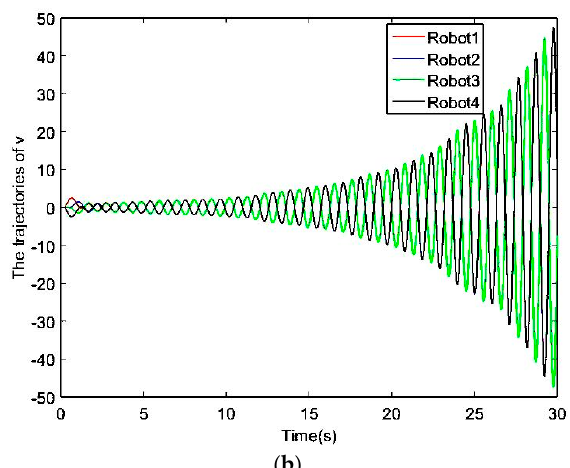
Figure 3. Experiment 1 Group 2 simulation results; x is position, v is velocity. ( a ) Trajectory of x changing with time; ( b ) Trajectory of v changing with time.